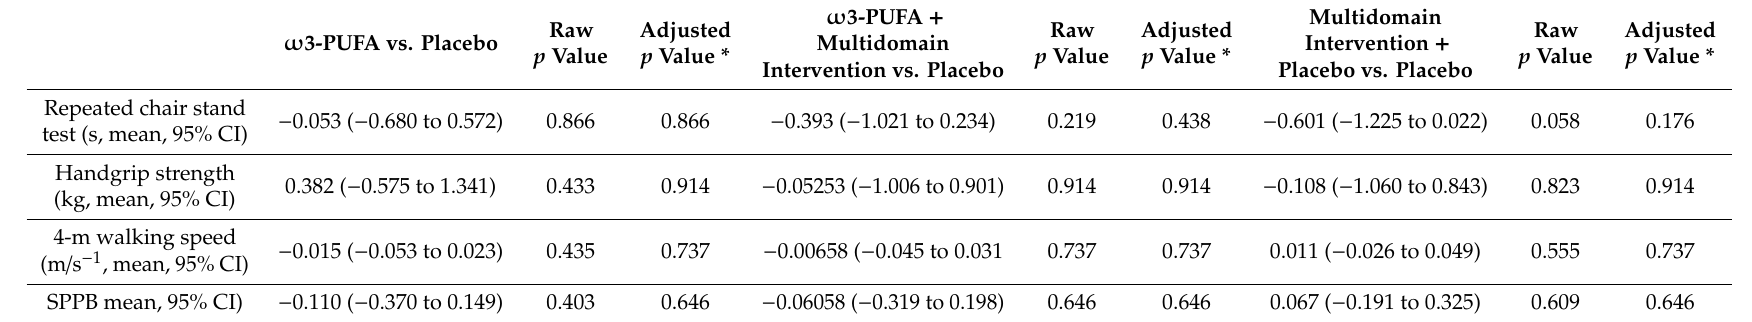
Table 3. Estimated 3-year between-group mean di ff erence in change in physical performances from baseline (95% CI).